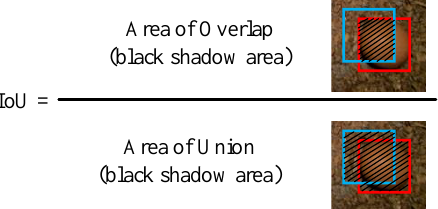
Figure 5. Illustration of intersection over union (IoU) calculation. The red square box is the ground truth box, the blue square box is the predicted box, and the black shadow areas are the overlap or union areas.